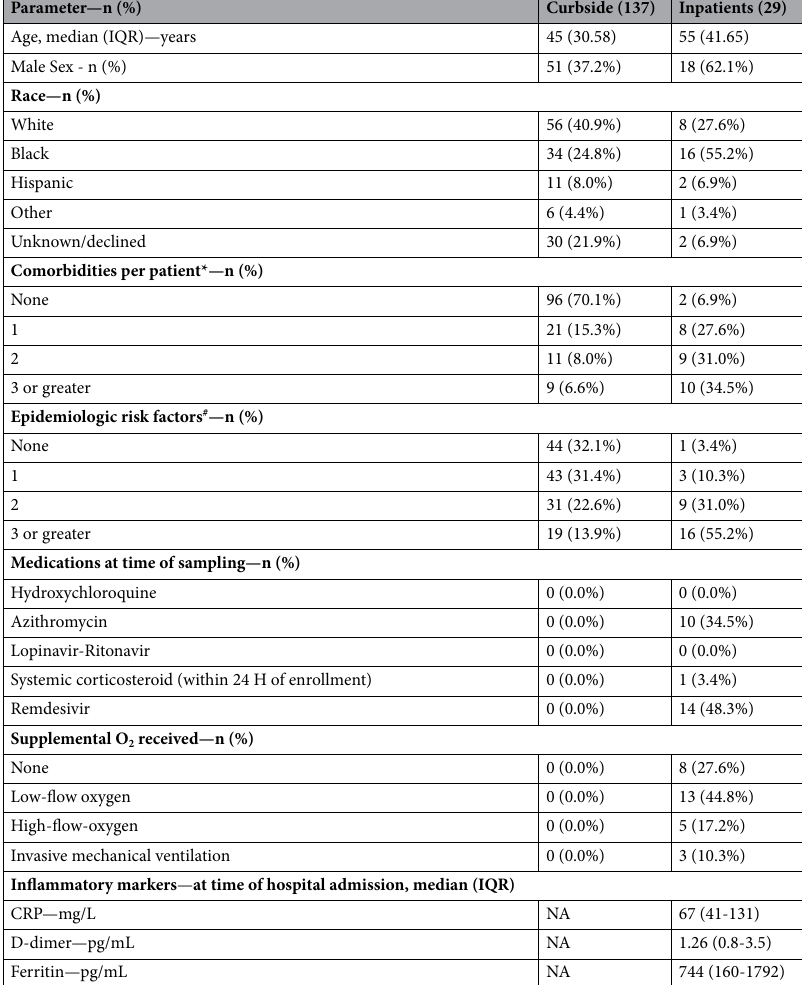
Table 1. Clinicopathological characteristics of the SARS-CoV-2 saliva testing participants. IQR interquartile range. *Comorbidities were defined as heart failure, coronary artery disease, hyperlipidemia, history of cancer, systemic hypertension, pulmonary hypertension, home oxygen use, chronic lung disease, immunodeficiency, end stage renal disease, obesity, and diabetes. # The risk factors were defined as being older than 60 years old, male, race (black, non-white Hispanic or Latino, American Indian, Alaskan native), presence of underlying comorbidity, and being